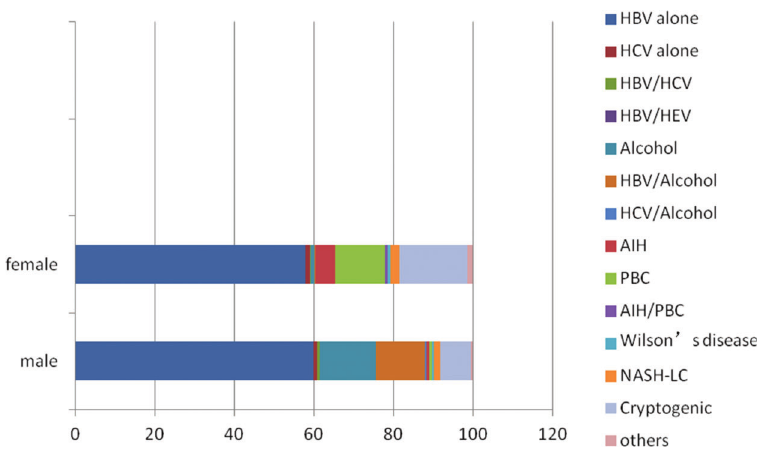
Figure 1 - Difference in etiologies between males and females.